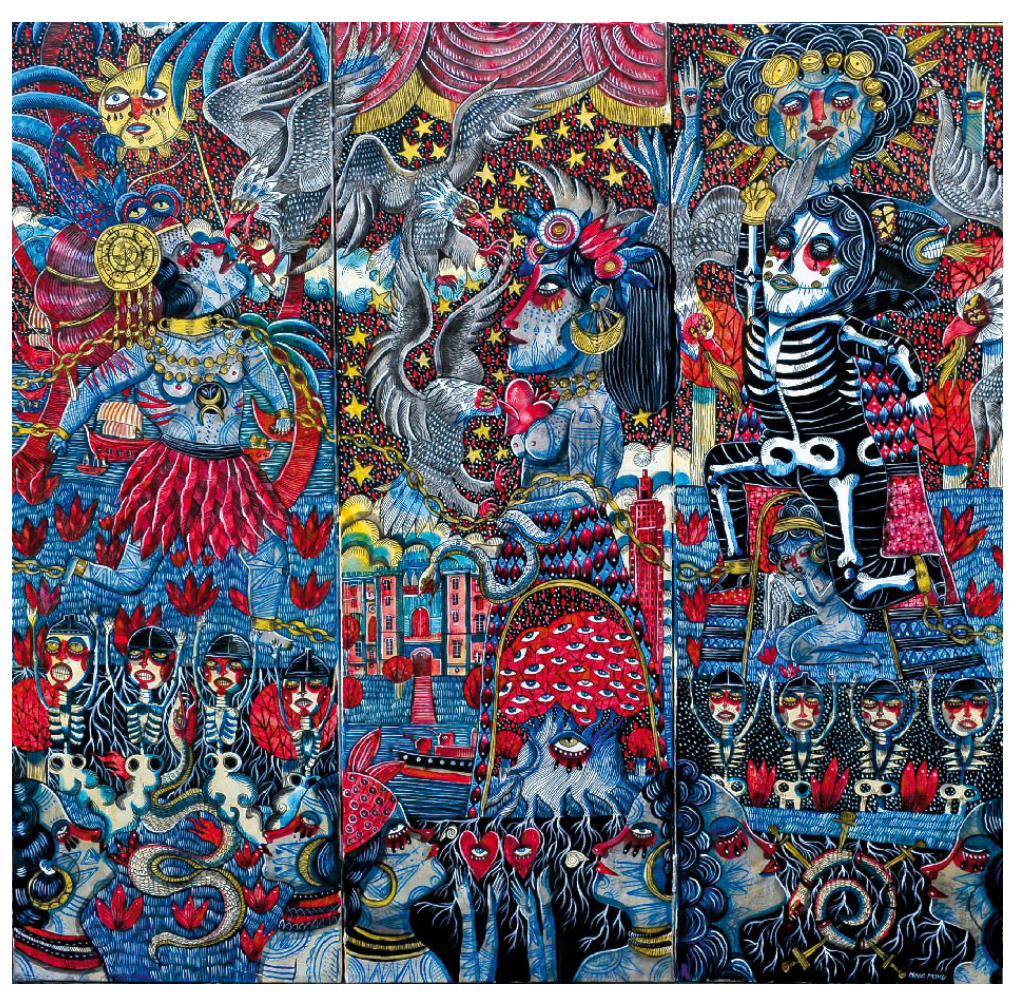
Figure 16. Am I not a (wo)man? (2016). By Mina Mond. Picture courtesy of the artist.